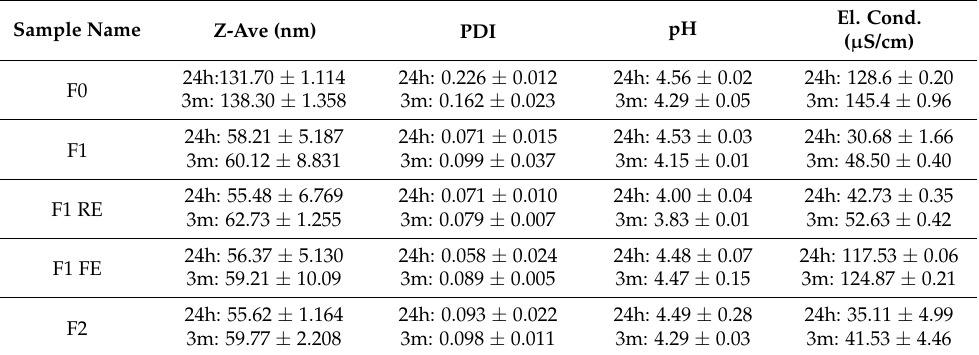
Table 2. Z-average droplet size (Z-ave) and polydispersity index (PDI) of the selected nanoemulsion samples, pH and electrical conductivity values, measured 24 h after preparation and after 3 months of storage at room temperature.